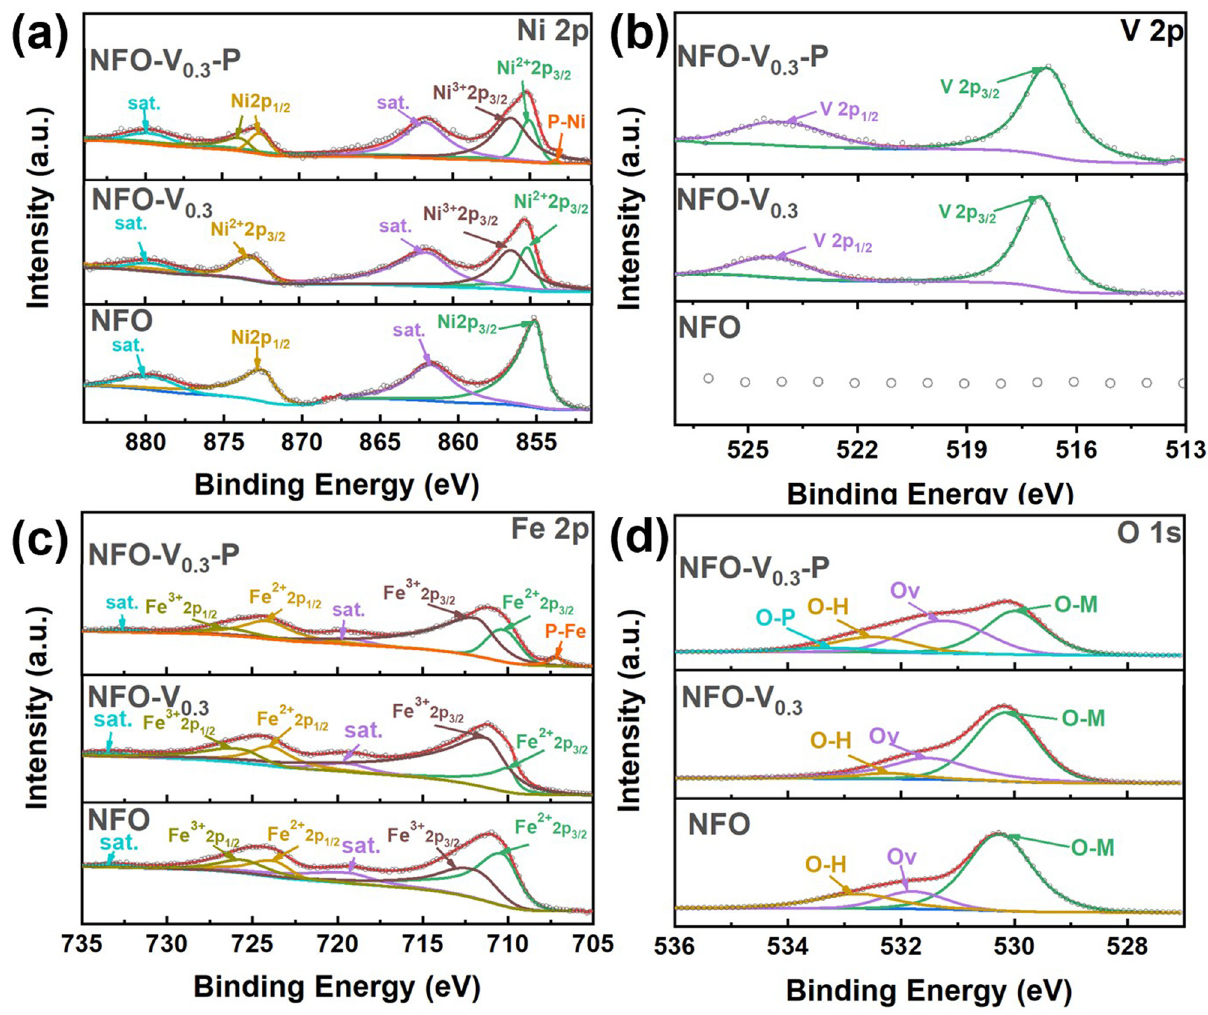
Figure 3: XPS spectra of NFO, NFO - V 0.3 , NFO - V 0.3 - P in ( a ) Ni 2p, ( b ) Fe 2p, ( c ) O 1 s, and ( d ) V 2p